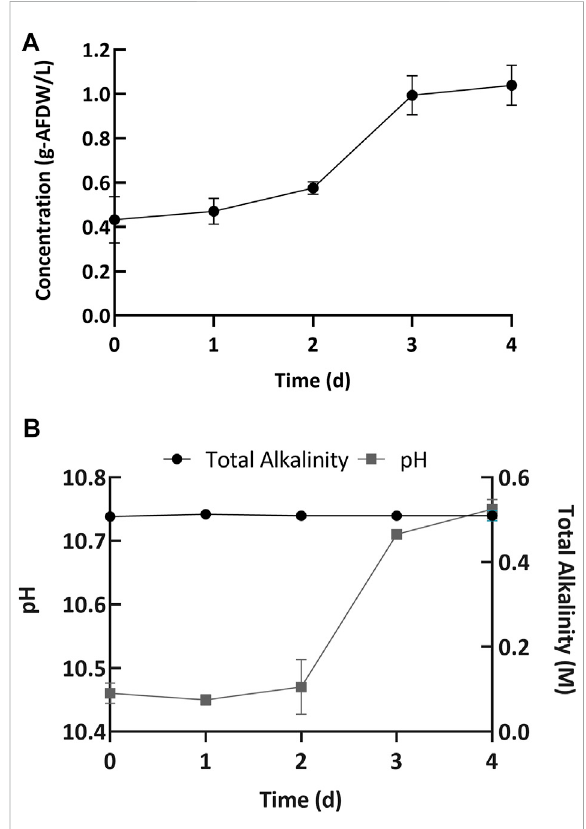
FIGURE 3 (A) Increase in the biomass concentration and (B) change in pH (left y -axis) and total alkalinity (right y -axis) over the incubation period. Error bars represent the standard deviation of the triplicate samples for each time